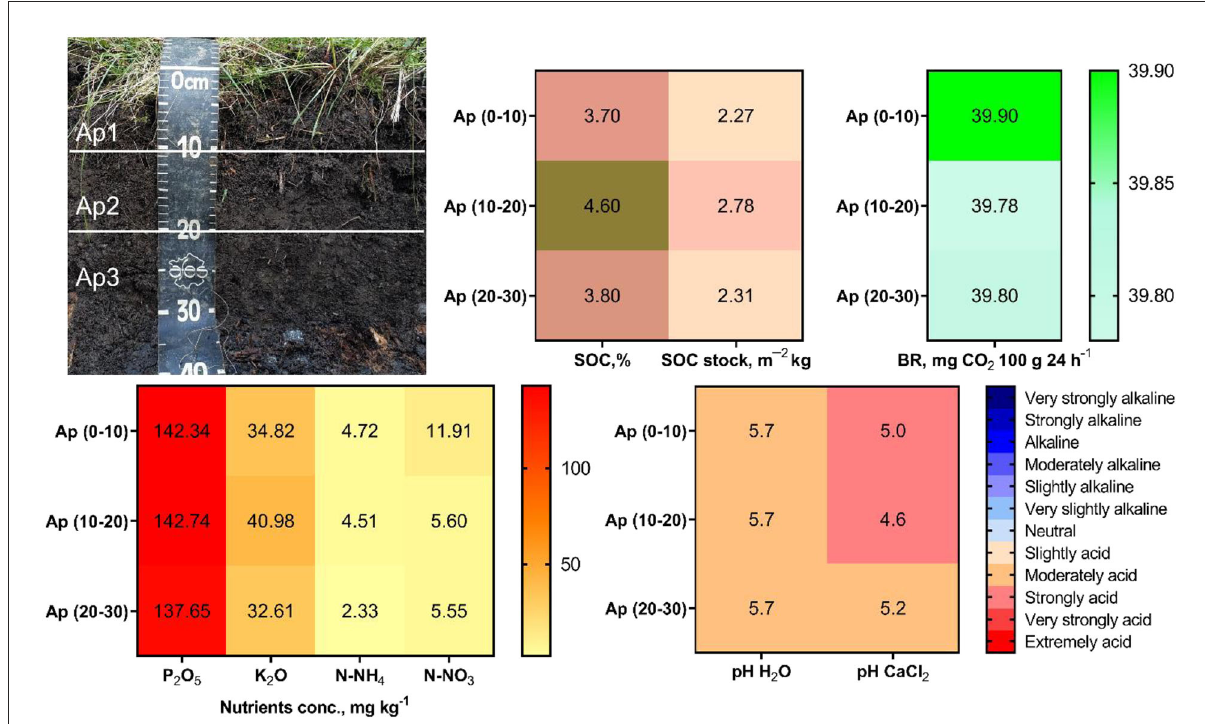
FIGURE8 Main soil properties in the abandoned greenhouse. Soil name: Hortic Anthrosol (WRB, 2015).